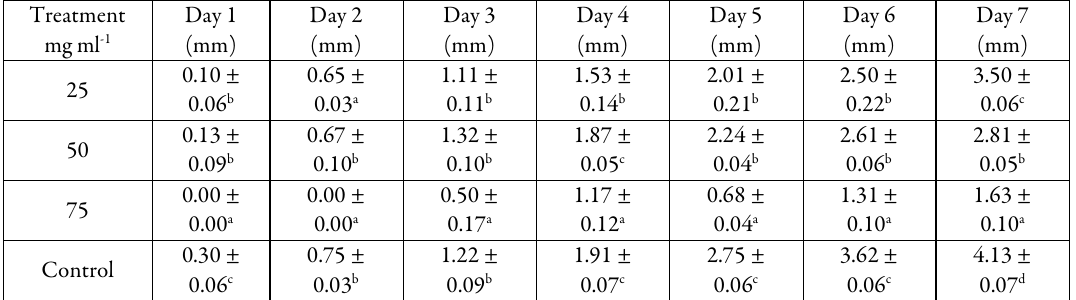
Table 2. In vitro inhibitory effect of C. papaya aqueous leaf extract on the mycelial growth of R. solani Treatment mg ml